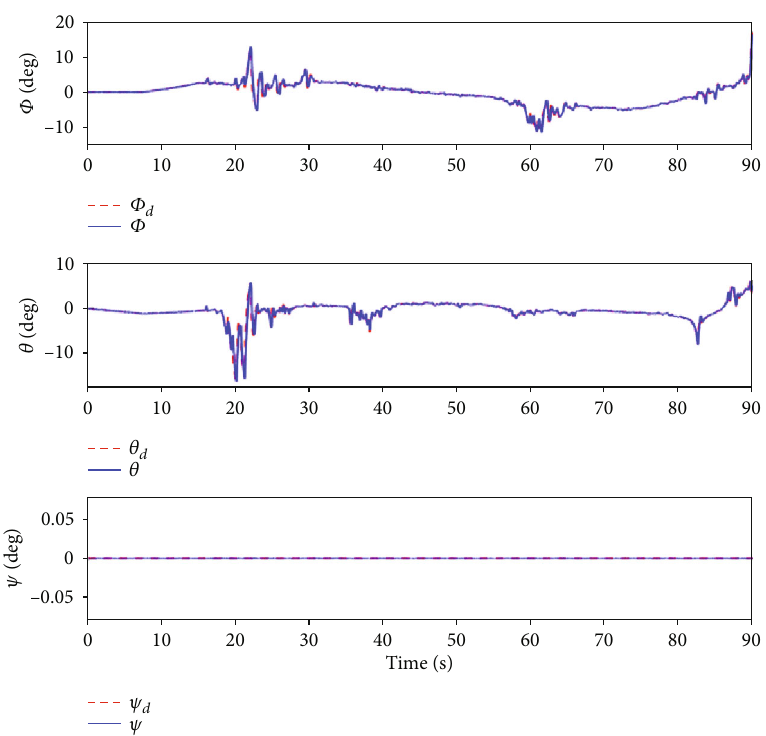
Þ : fl ight scenario 1. d